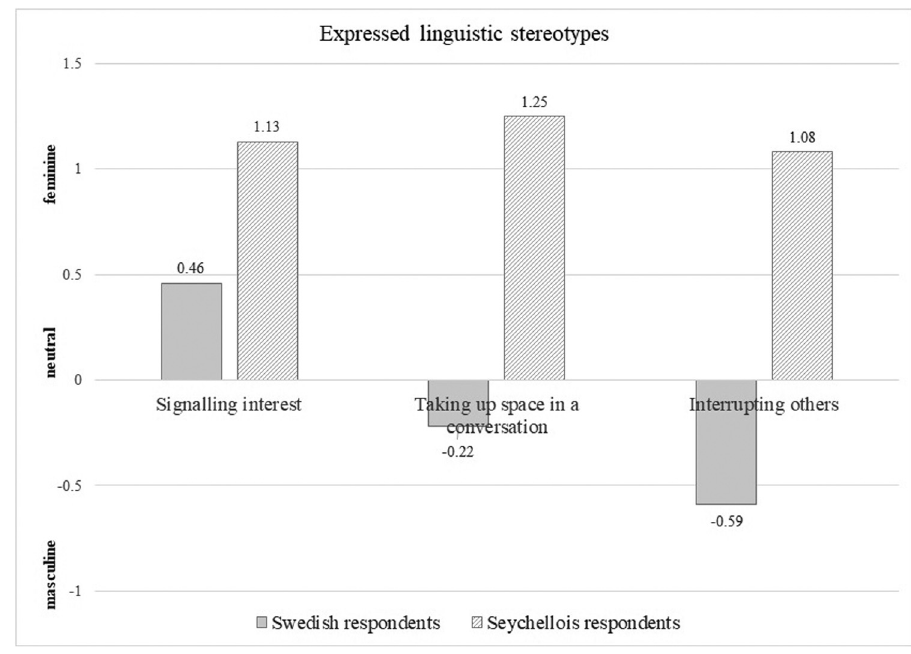
Figure 1: Linguistic gender stereotypes Swedish vs Seychellois